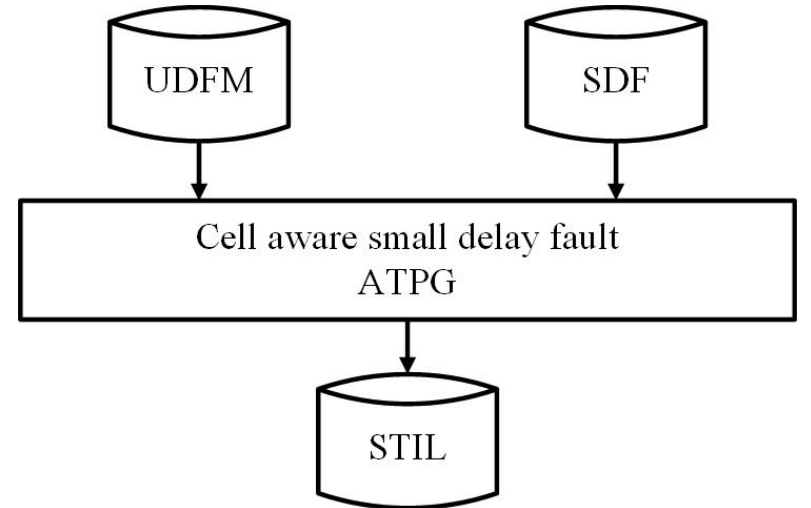
Figure 10. ATPG generation flow through CA test for small delay